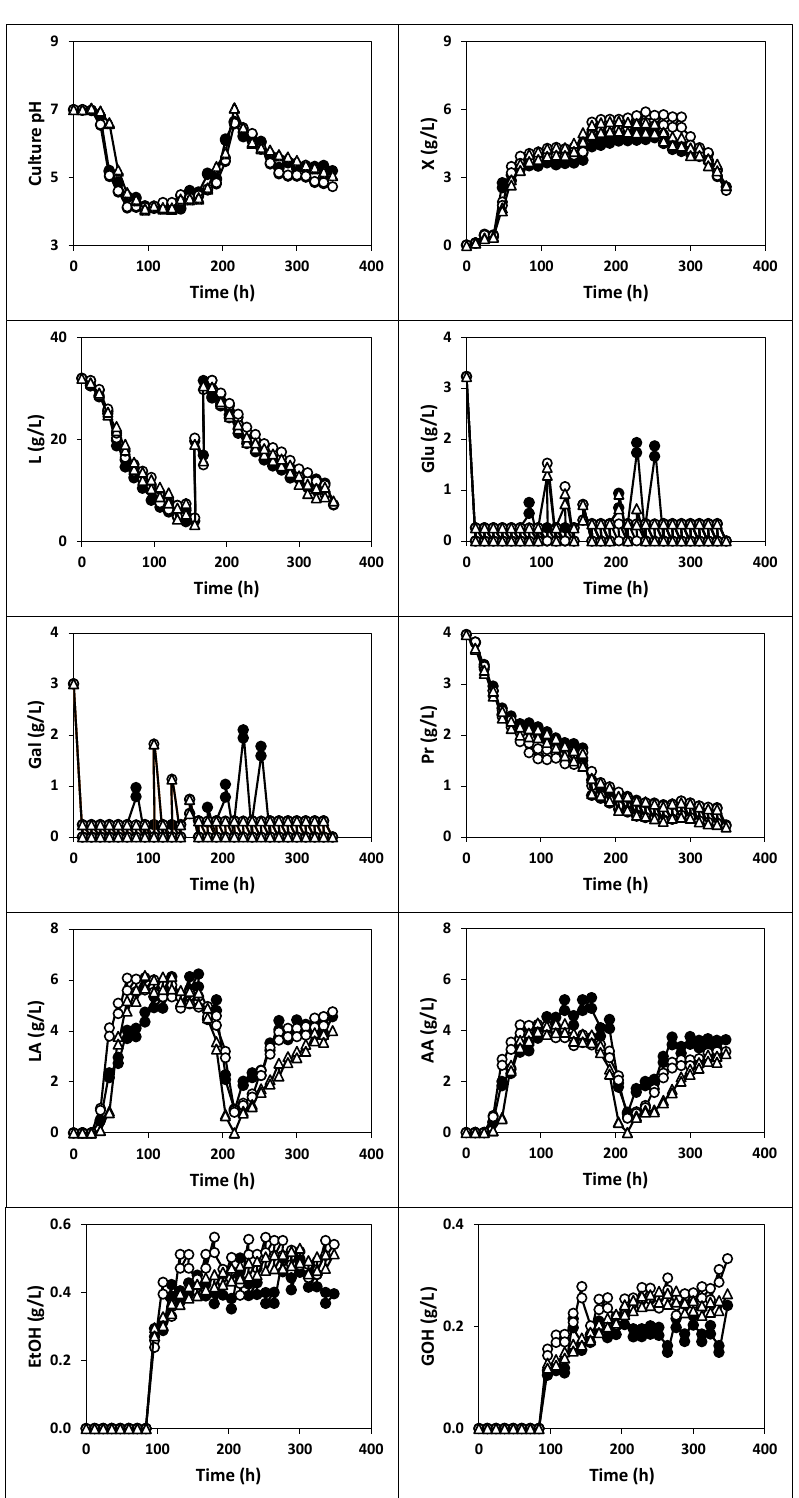
Figure 2. Fermentation kinetics (200 rpm) of whey with total free biomass from whole ( black circles ), semi-skim ( white circles ) and skim ( triangles ) milk previously fermented with kefir grains AGK1 with stirring at 150 rpm. X: biomass, L: lactose, Glu: glucose, Gal: galactose, LA: lactic acid, AA: acetic acid, Pr: proteins, EtOH: ethanol, GOH: glycerol. The experimental data represent the means of two cultures carried out in parallel with two analytical replicates each.